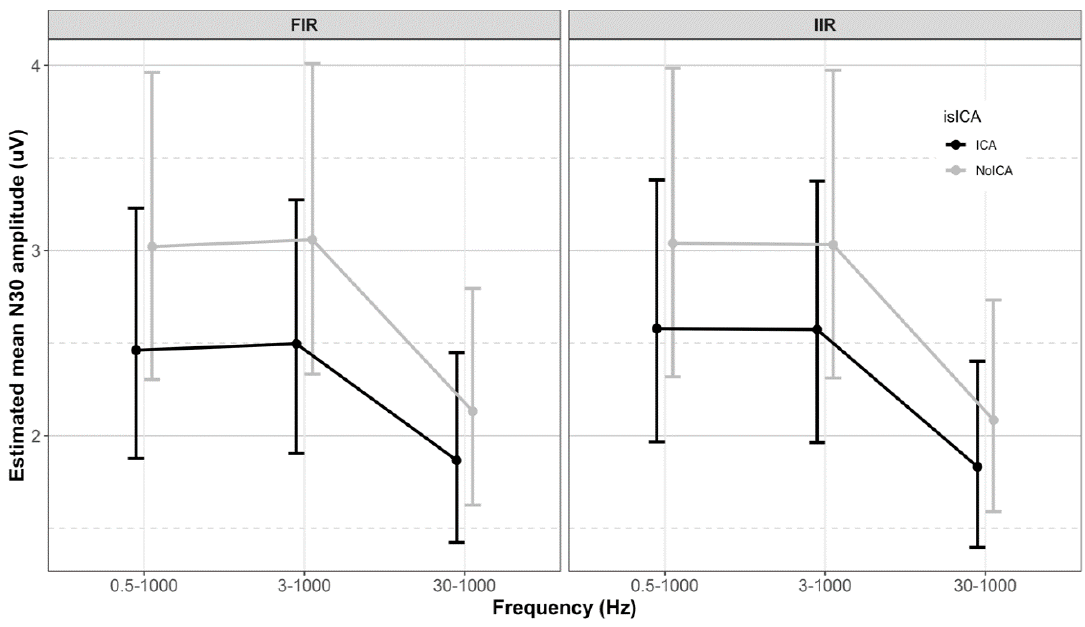
Figure 5. The e ff ect of cuto ff frequency and the use of ICA. The error bar shows estimated mean N30 Figure 5. The effect of cutoff frequency and the use of ICA. The error bar shows estimated mean N30 amplitude ± 95% CI. The 30–1000 Hz band showed significantly lower N30 amplitude compared to the 0.5–1000 Hz and 3–1000 Hz bands. The use of ICA significantly reduced the N30